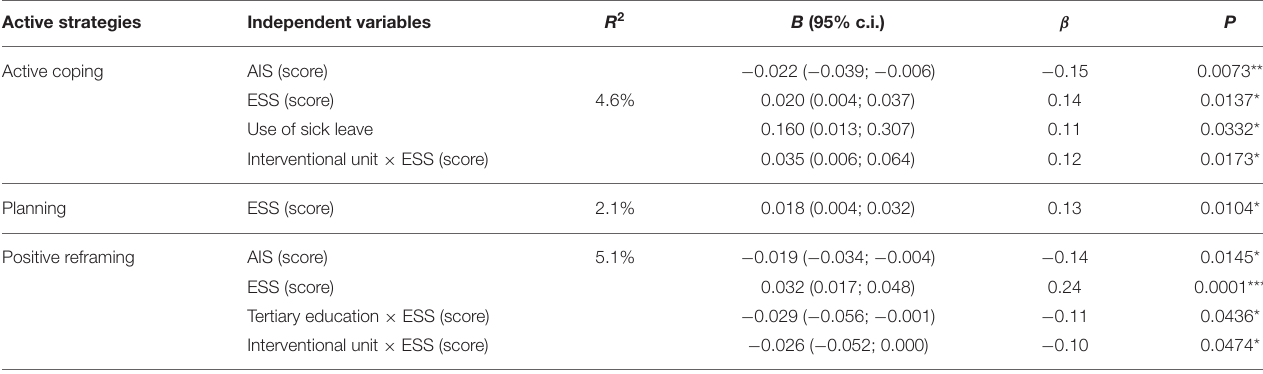
TABLE 3 | Regression models for active strategies ( N = 448).